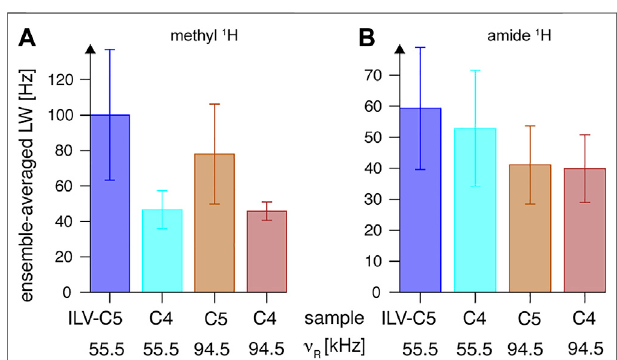
FIGURE 12 | Linewidths (full widths at half height) of (A) methyl and (B) backbone amide 1 H resonances observed in 2D 13 C- 1 H and 15 N – 1 H CP- HSQCspectra,respectively,for “ ILV-C4 ” (at ν R =55.5 kHzin cyan ,andat ν R = 94.5 kHz in red ) and “ ILV-C5 ” (at ν R = 55.5 kHz in blue, and at ν R = 94.5 kHz in tan ) SH3 samples on an 18.8-T spectrometer. Linewidths observed in each case were averaged over all resonances, and the error bars indicate the standard deviation (the dispersion of values observed for all residues), not the precision of linewidth determination.